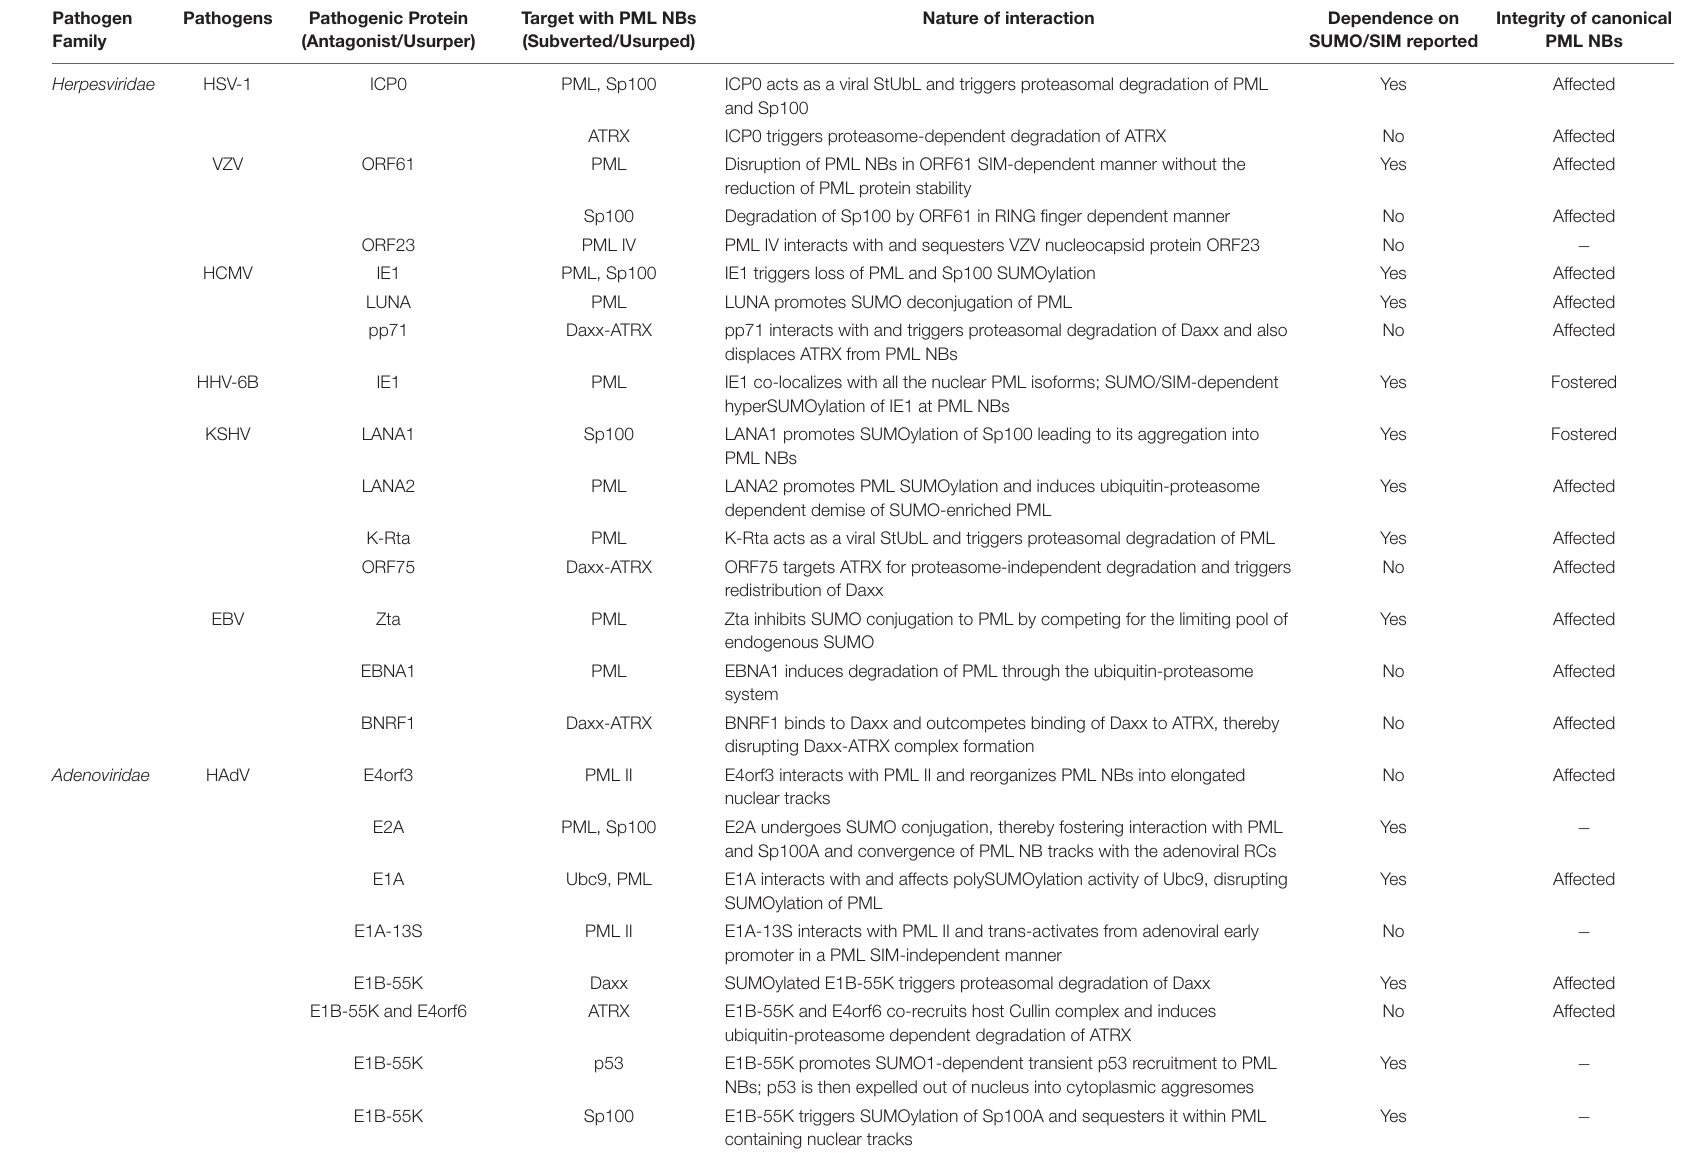
TABLE 1 | SUMO/SIM-dependent/independent interaction profiles of different pathogens with PML NB components. Pathogen